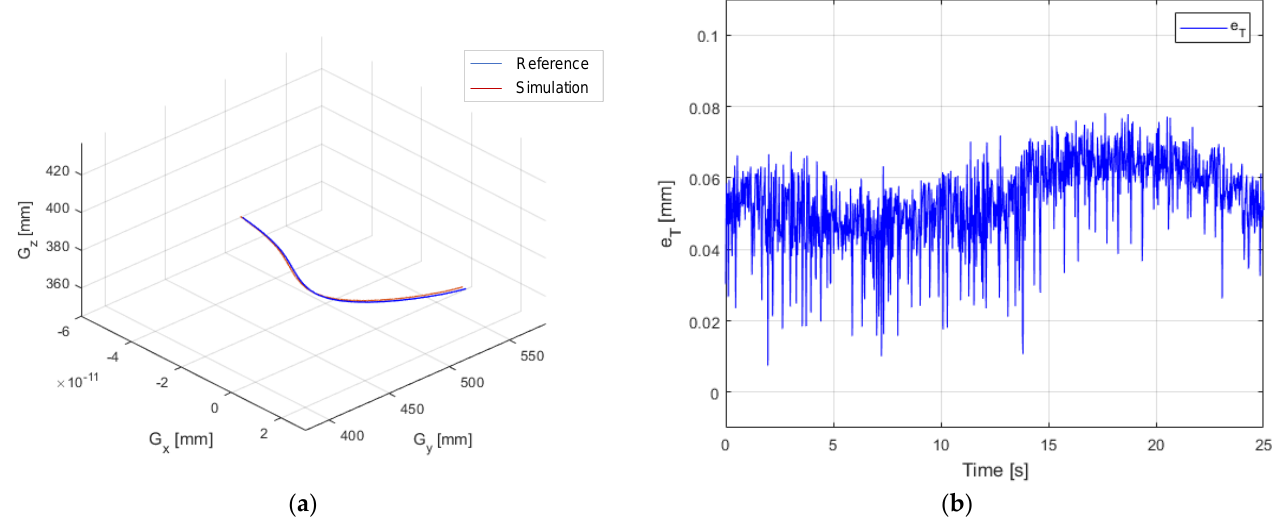
Figure 12. Simulation results ( a ) end-effector trajectory ( b ) position error.